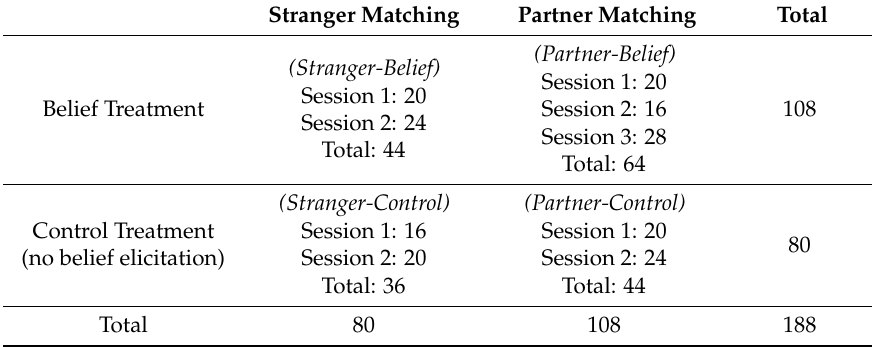
Table 1. Overview of experimental